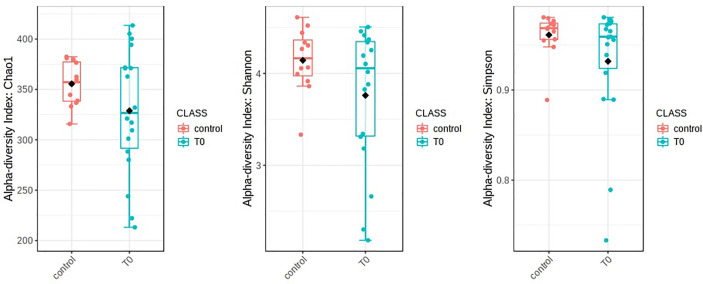
Alpha diversity in patients with COVID-19 (T0) in respect to control subjects. Alpha diversity analysis was evaluated by means of several metrics: Chao1, Shannon, and Simpson indices. Overall, the plots do not show any significant difference between T0 and Control (statistical analysis by Wilcoxon rank-sum test Mann-Whitney). Nevertheless, a soft trend of decreased richness in T0 respect to Control was observed.